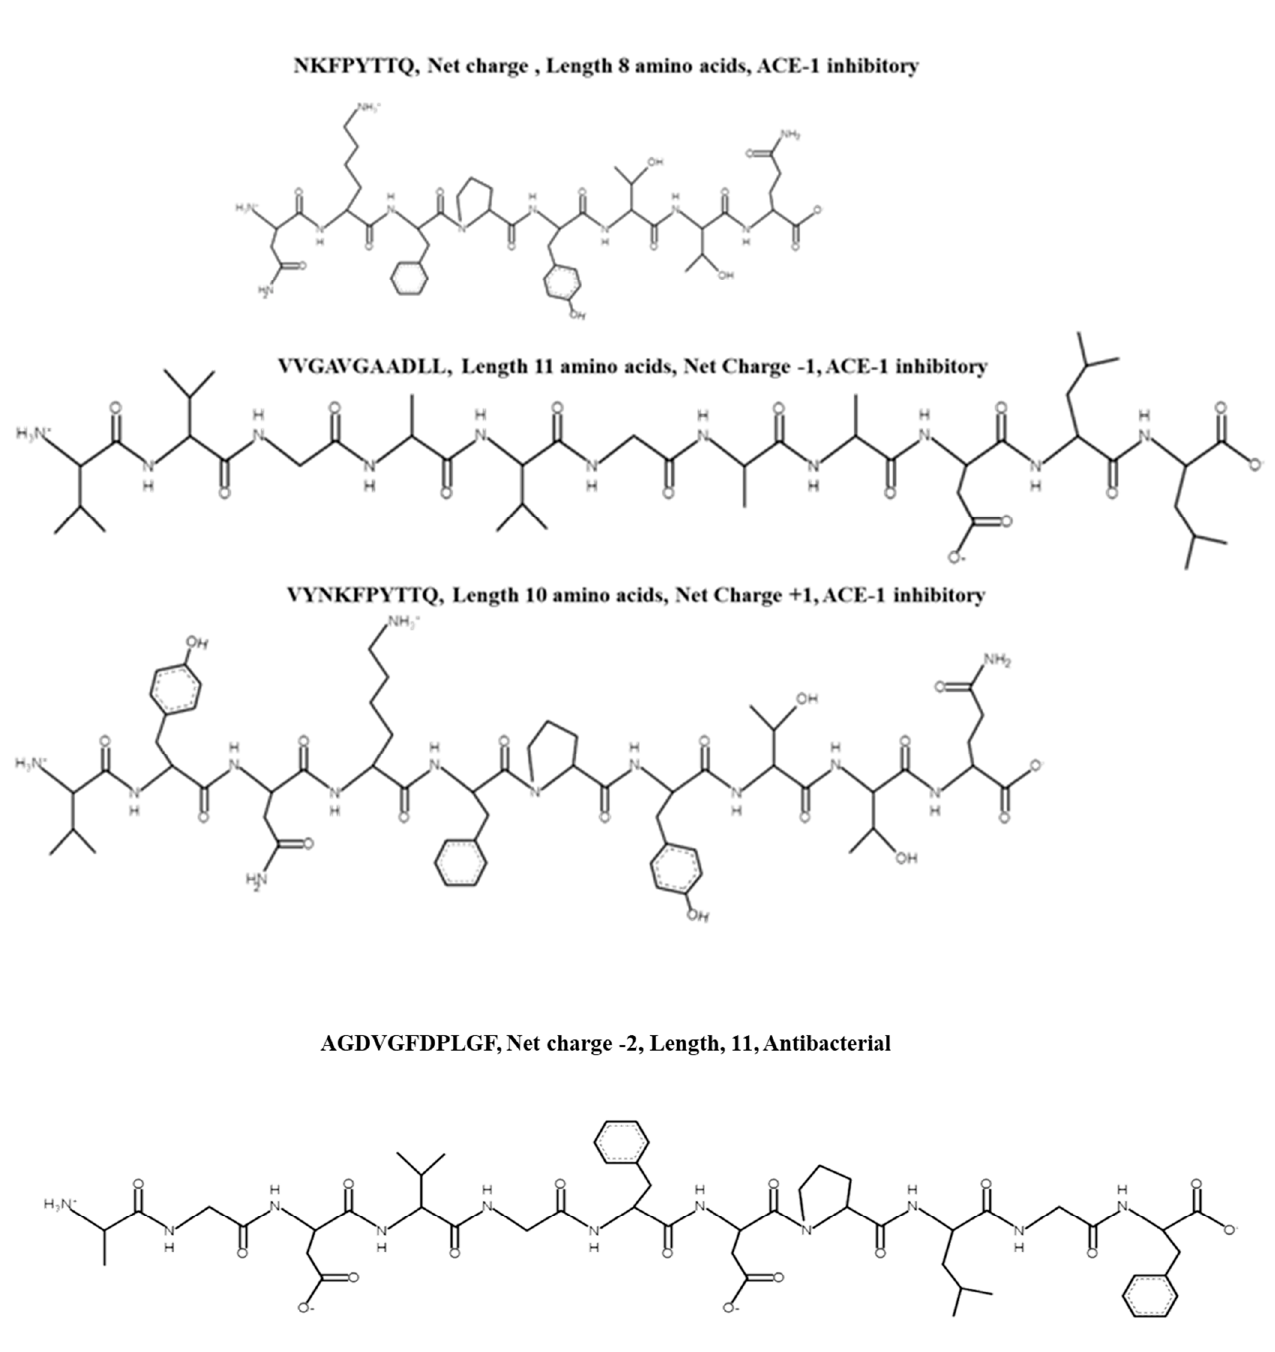
Figure 4. Chemical structure and characteristics of synthesised peptides from Nannochloropsis oc- ulata xy-lanase treated protein with ACE-1 inhibitory activities. Chemical structures were drawn using PepDraw (PepDraw (tulane.edu))–accessed on 22 August